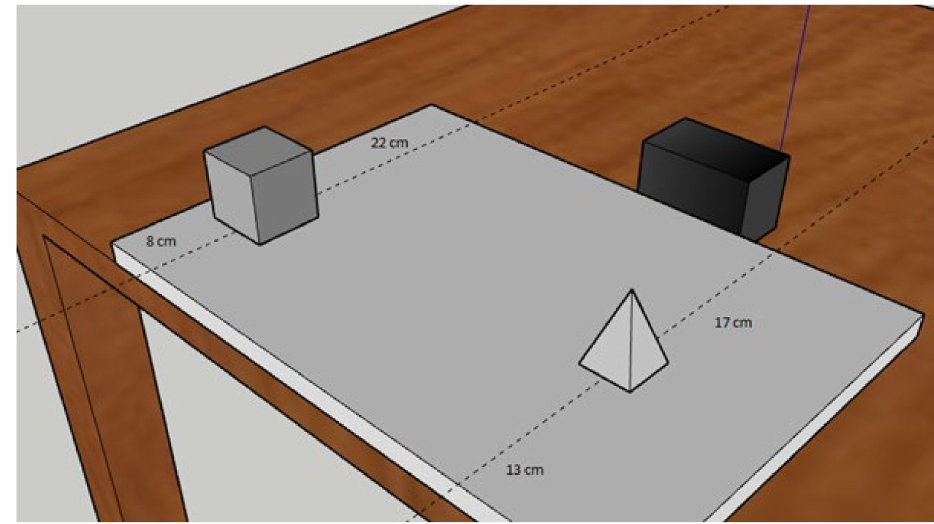
Figure 2. This image is only intended to show how the difficulties were calculated within each trial. As can be seen, the metric difficulty with respect to the participant’s position (shown in the image by the edge of the table) was 5 cm (the cube was positioned at 8 cm from the participant and the pyramid at 13 cm), the same level of metric difficulty results with respect to the black bar (22 − 17 = 5